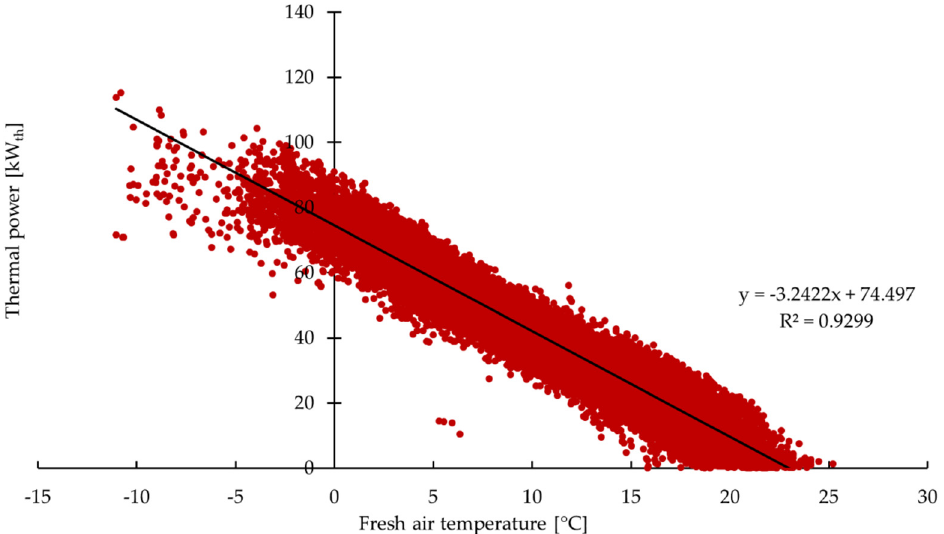
. Figure 5. Correlation of the thermal power Q HR,th [kW th ] of the two heat exchangers and the fresh Figure 5. Correlation of the thermal power Q(cid:4662) (cid:2892)(cid:2902),(cid:2930)(cid:2918) [kW th ] of the two heat exchangers and the fresh air temperature [ ◦ C] when heat exchangers heated the incoming fresh air temperature [°C] when heat exchangers heated the incoming fresh air.